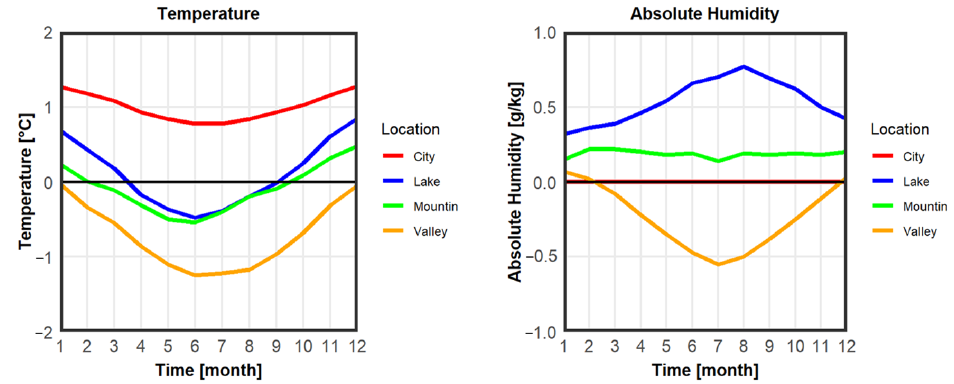
Figure 8. Local climate model using correction functions for locally different exposure conditions.